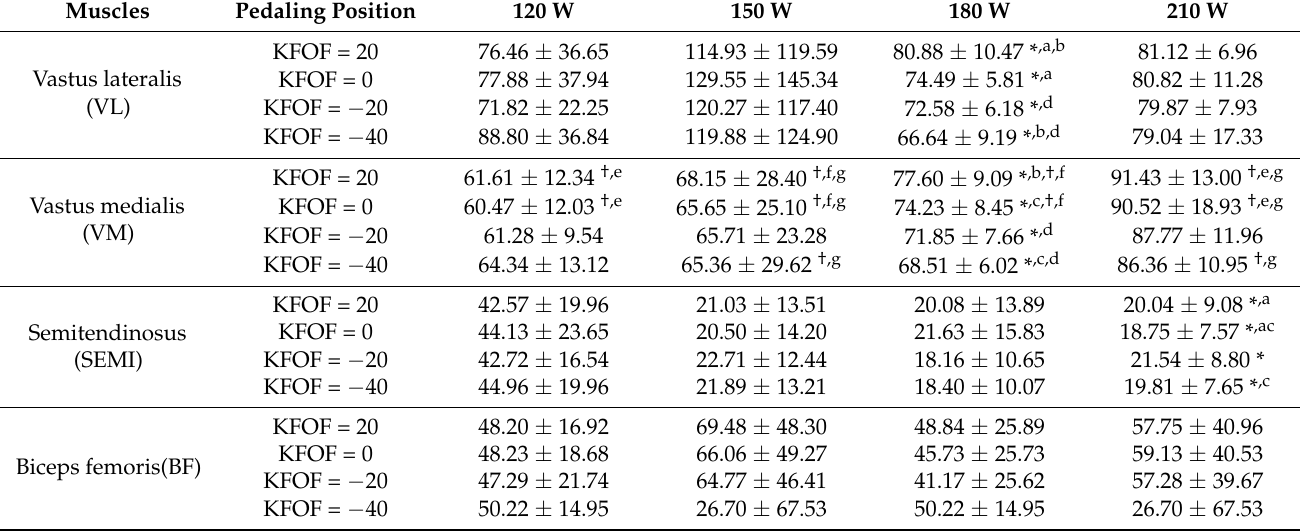
Table 1. The normalized RMS value (%MVC, mean ± SD) during different pedaling postures and workloads in the short-distance ride test (SRT).